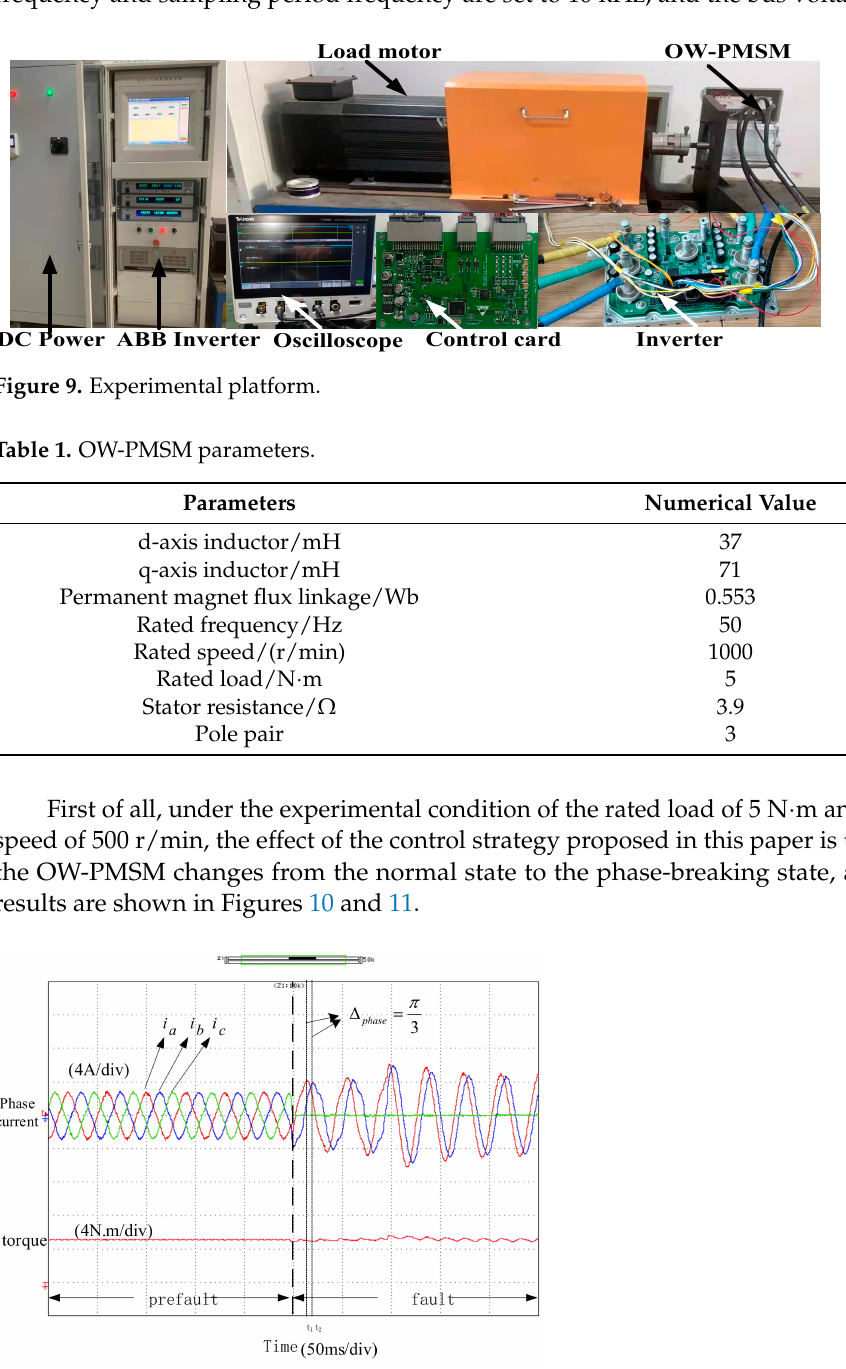
Figure 10. The dynamic comparison before and after the open-phase fault.